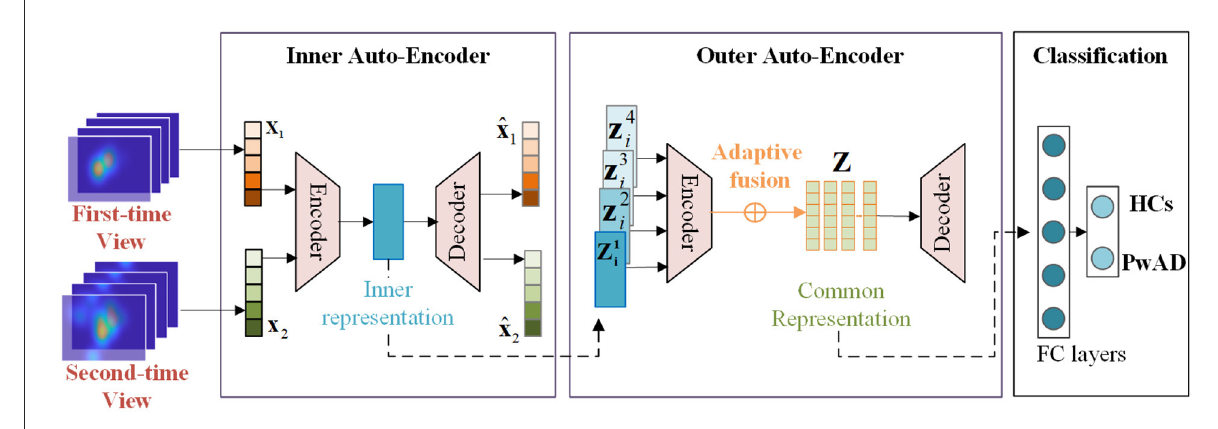
FIGURE4 This figure shows the whole workflow of the proposed NeAE-Eye network. The NeAE-Eye model has three main modules, including inner autoencoder module, outer autoencoder module, and classifier